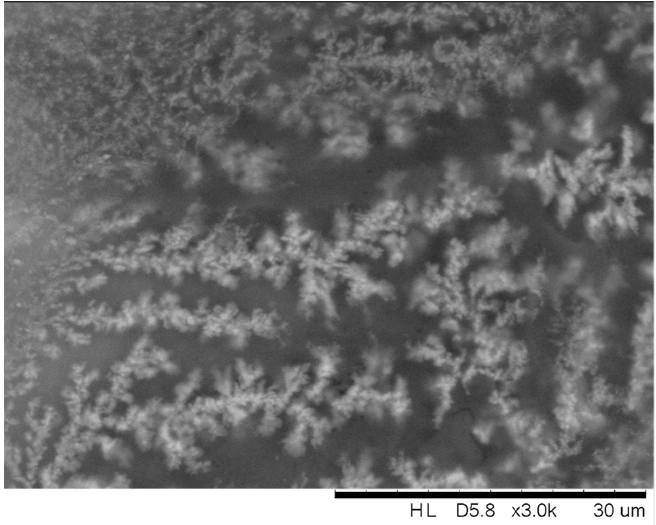
Figure 4. Scanning electron microscopy (SEM) image of crystallized nanocomposite film p(MA+CNC) with MA/CNC = 1/200 after 1 week.